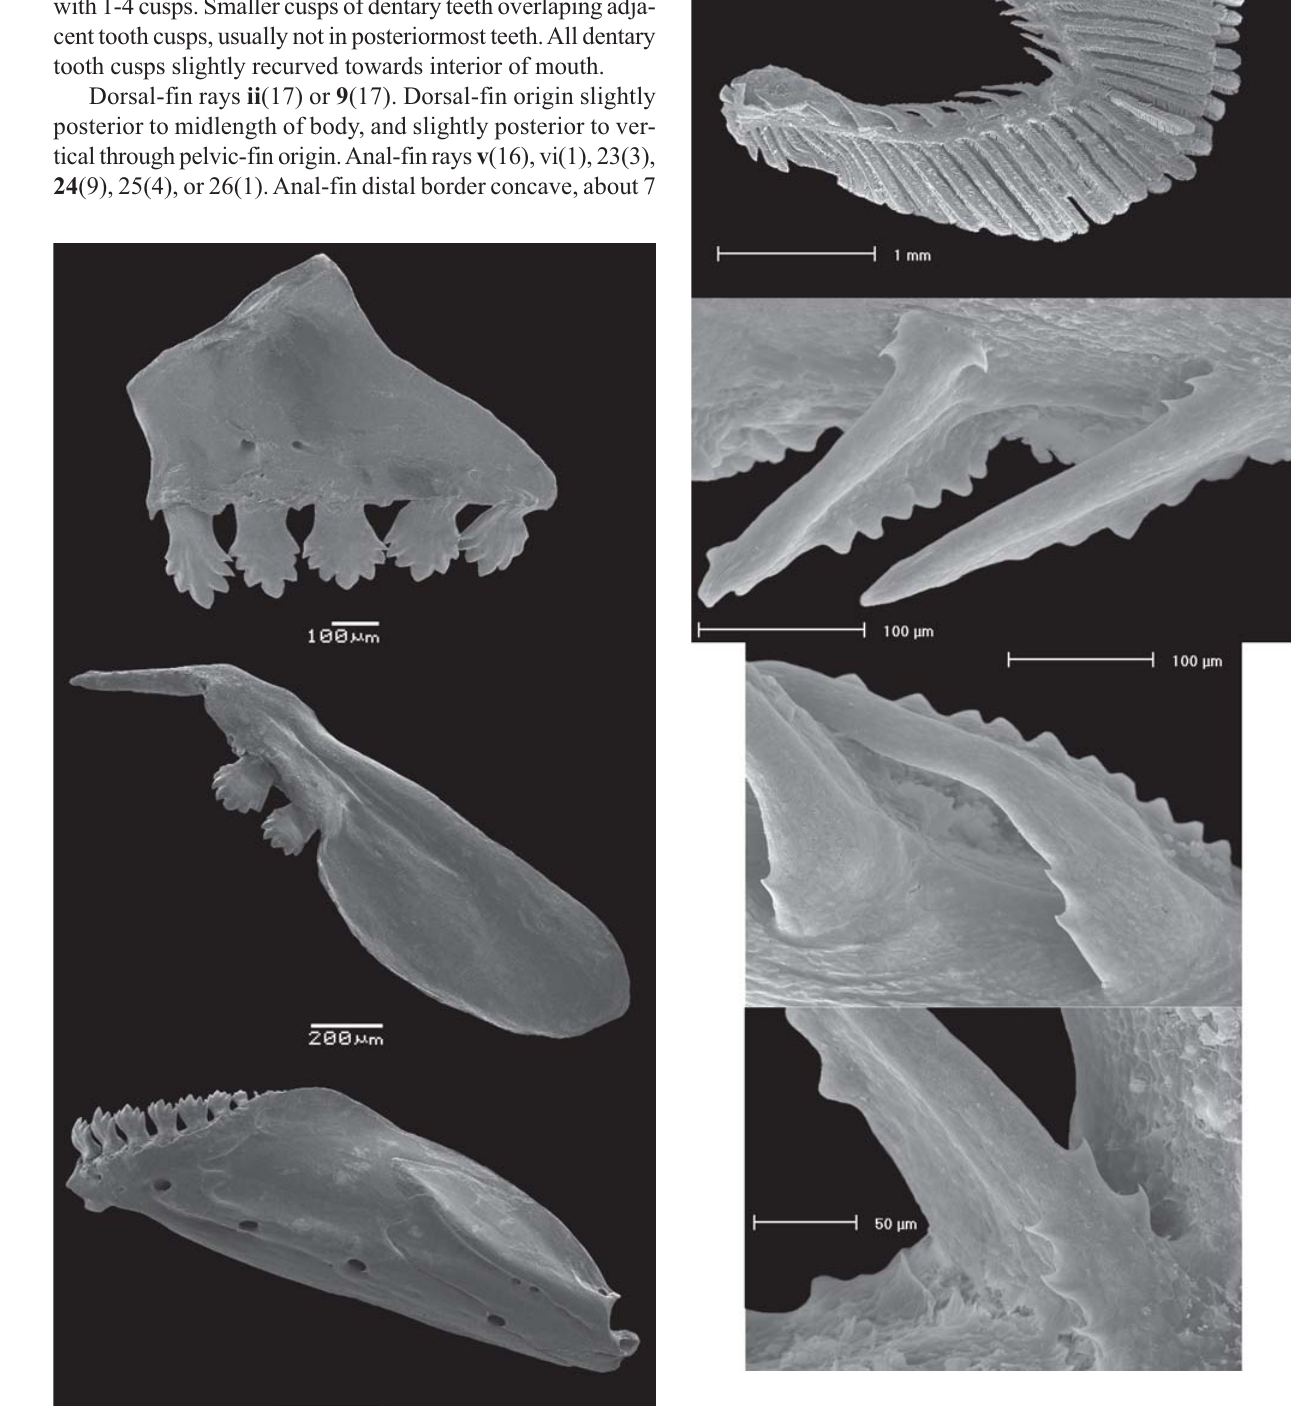
Fig. 22. First gill arch of Odontostilbe nareuda , FMNH 106433, unsexed 29.2 mm SL. SEM photographs of the left side gill arch (top), in detail gill rakers on upper branchial branch (middle), and gill rakers on lower branchial branch (bottom). Lateral